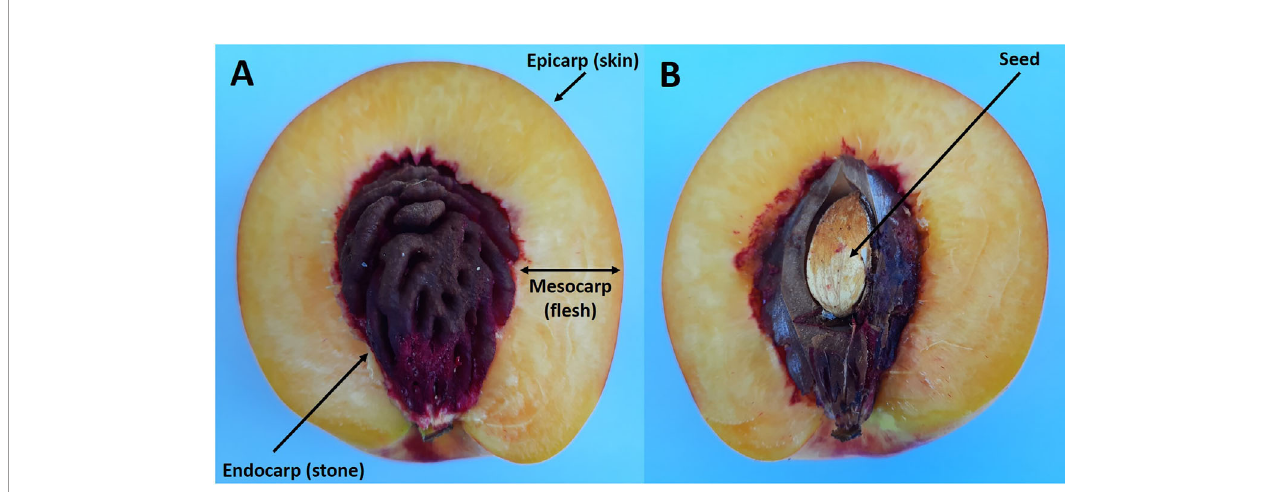
FIGURE 1 | Longitudinal section of a ripe nectarine fruit showing the fl esh and stone (A) . Same fruit but with the endocarp cut to reveal the enclosed seed (B)